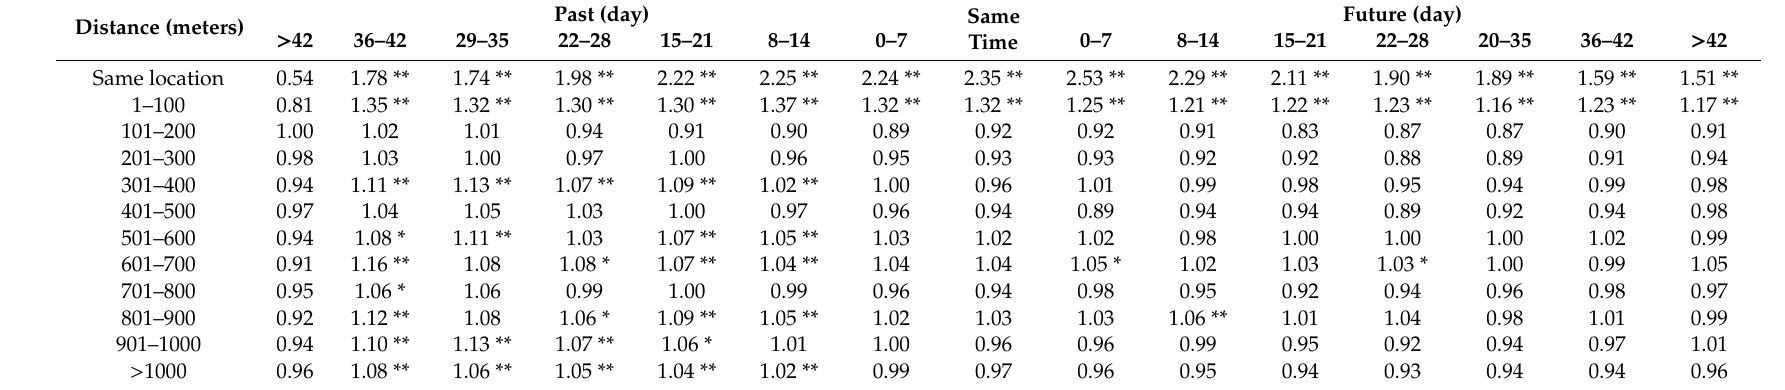
Table 6. Risk of VMVT after a PP